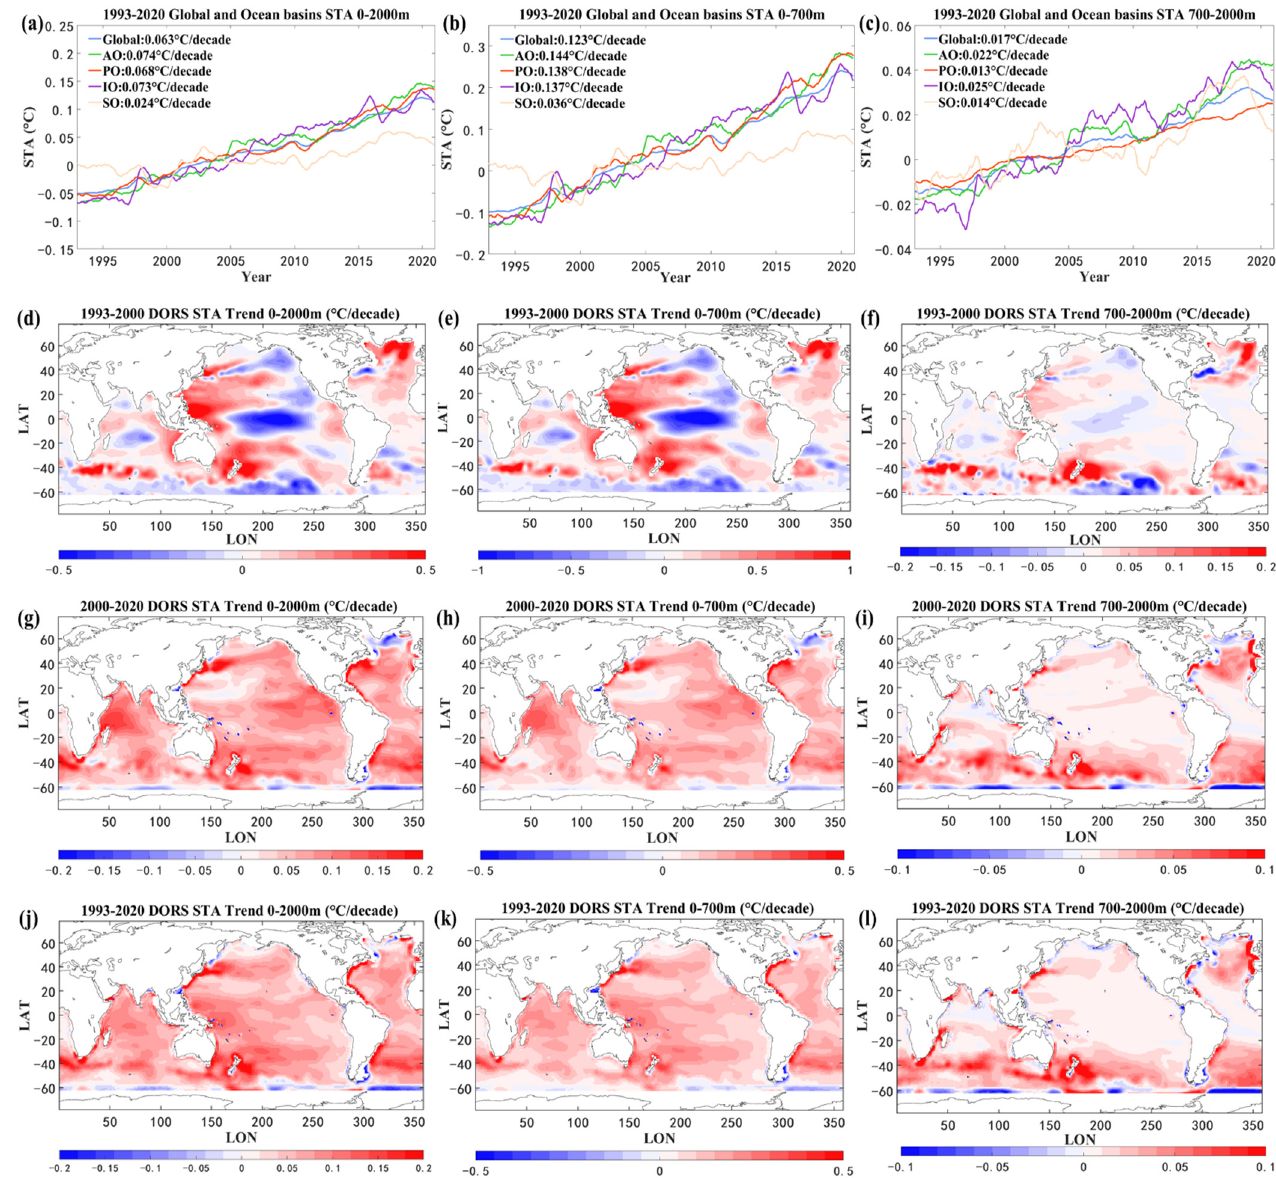
Figure 14. ( a – c ) Long-term time series trends of the global ocean and ocean-basin-scale subsurface